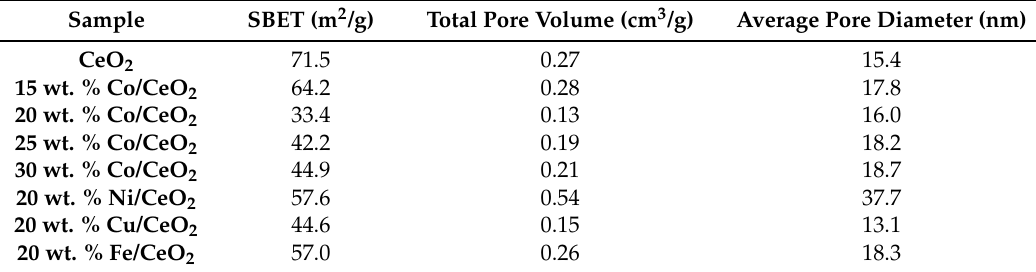
Table 1. Textural characteristics of M/CeO 2 (M: Fe, Co, Ni, Cu) catalysts. Sample